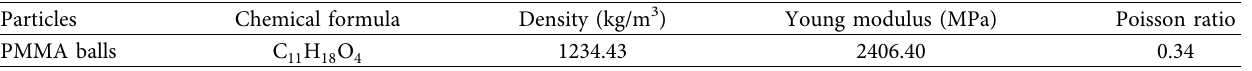
Table 6: PMMA characteristics.